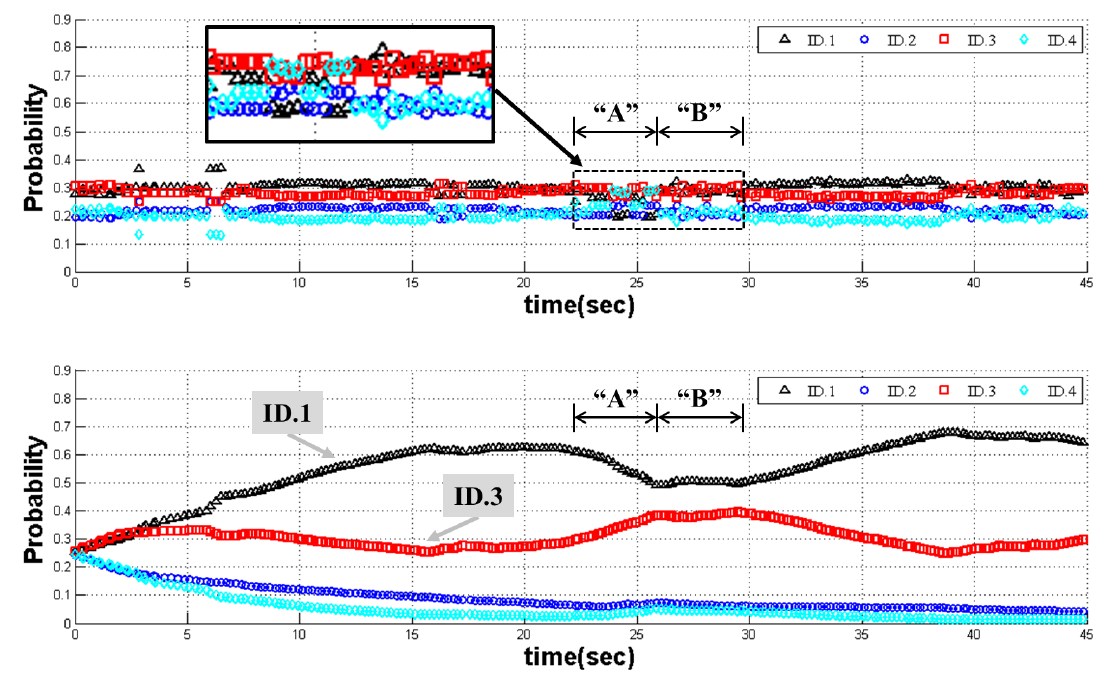
Figure 14. Trend line of probability ID.1: these graphs show the results of the SMI method [23] (top) and the proposed framework method (bottom). Table 4. Recognition results of the SMI method.